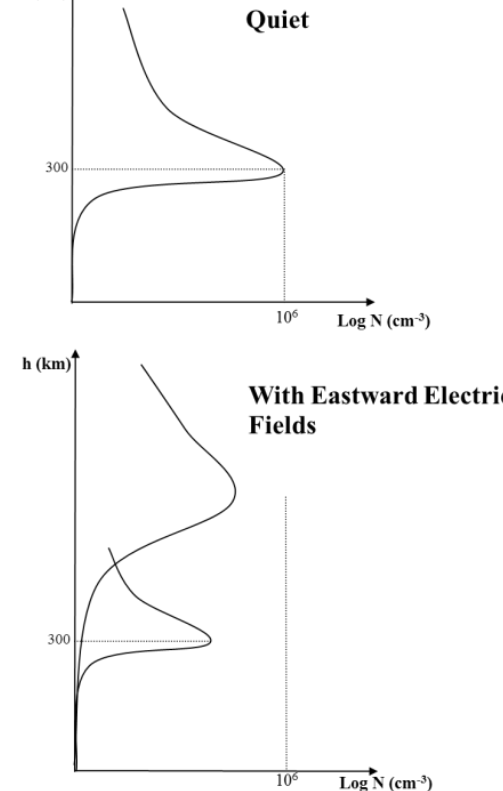
Fig. 4. A schematic showing the effect of uplifting the F-region ionosphere. The top panel shows the quiet time dayside configuration. The bottom panel shows how a new ionosphere is created after the old ionosphere is convected to higher heights during a storm-time PPEF event. Taken from Tsurutani et al. (2004) figure 12.